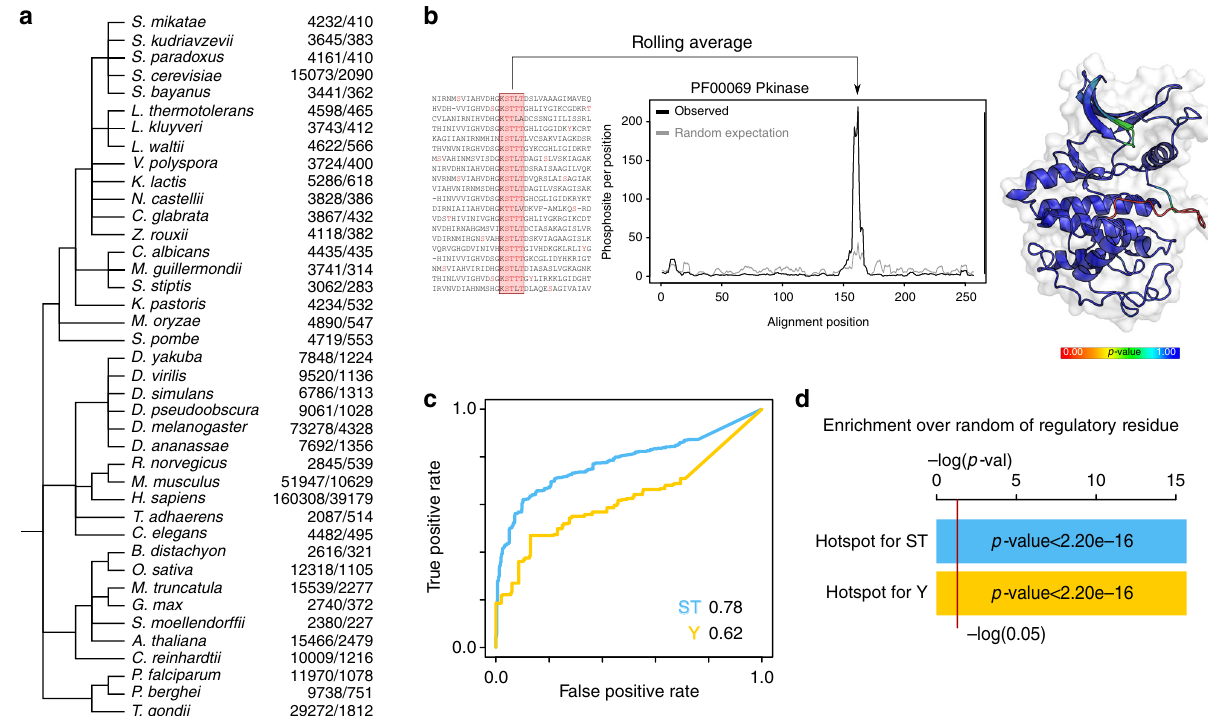
Fig. 1 Prediction of phosphorylation hotspots regions for eukaryotic domain families. a Phylogenetic tree of the species from which phosphorylation data has been obtained. The numbers in the left column correspond to the phosphosites per species obtained and the right column the phosphosites found within Pfam domains. b Hotspot regions are de fi ned as those having higher than randomly expected number of phosphorylation. A rolling window is used to count the observed average number of phosphosites in the alignment (black line) and a background expectation is calculated from random sampling (gray line and gray band for standard deviation). A p -value is calculated for the enrichment of phosphorylation at each position and projected onto structural models. c The capacity to discriminate between phosphosites of known function from other phosphosites was tested using a ROC curve. We compared the discrimination power of the hotspot p -value (blue line for ST and yellow line for Y). d Enrichment over random of human phosphosites with known functions for residues predicted as a hotspot region when compared with the rest of the domain (blue for ST and yellow for Y; p -value s for Fisher ’ s exact